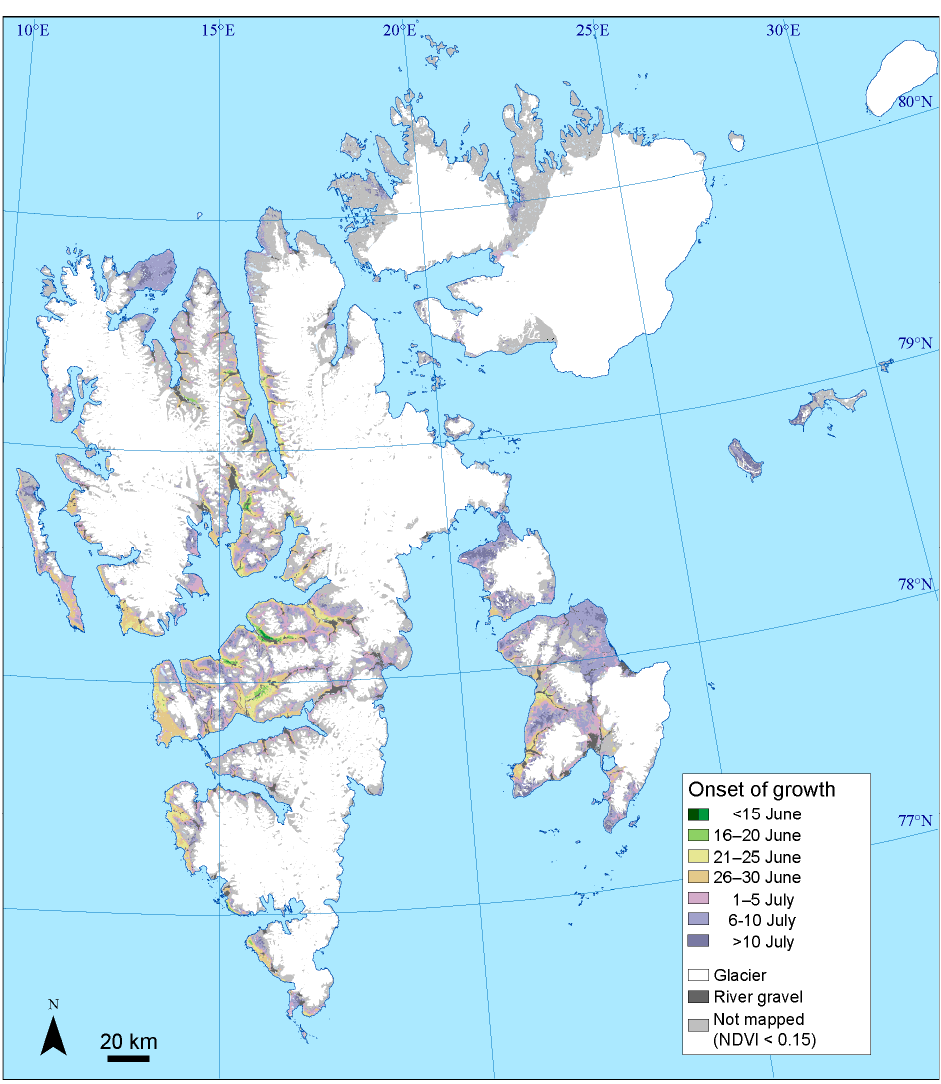
Figure 4. Mean (2000–2020) onset of vegetation growth.